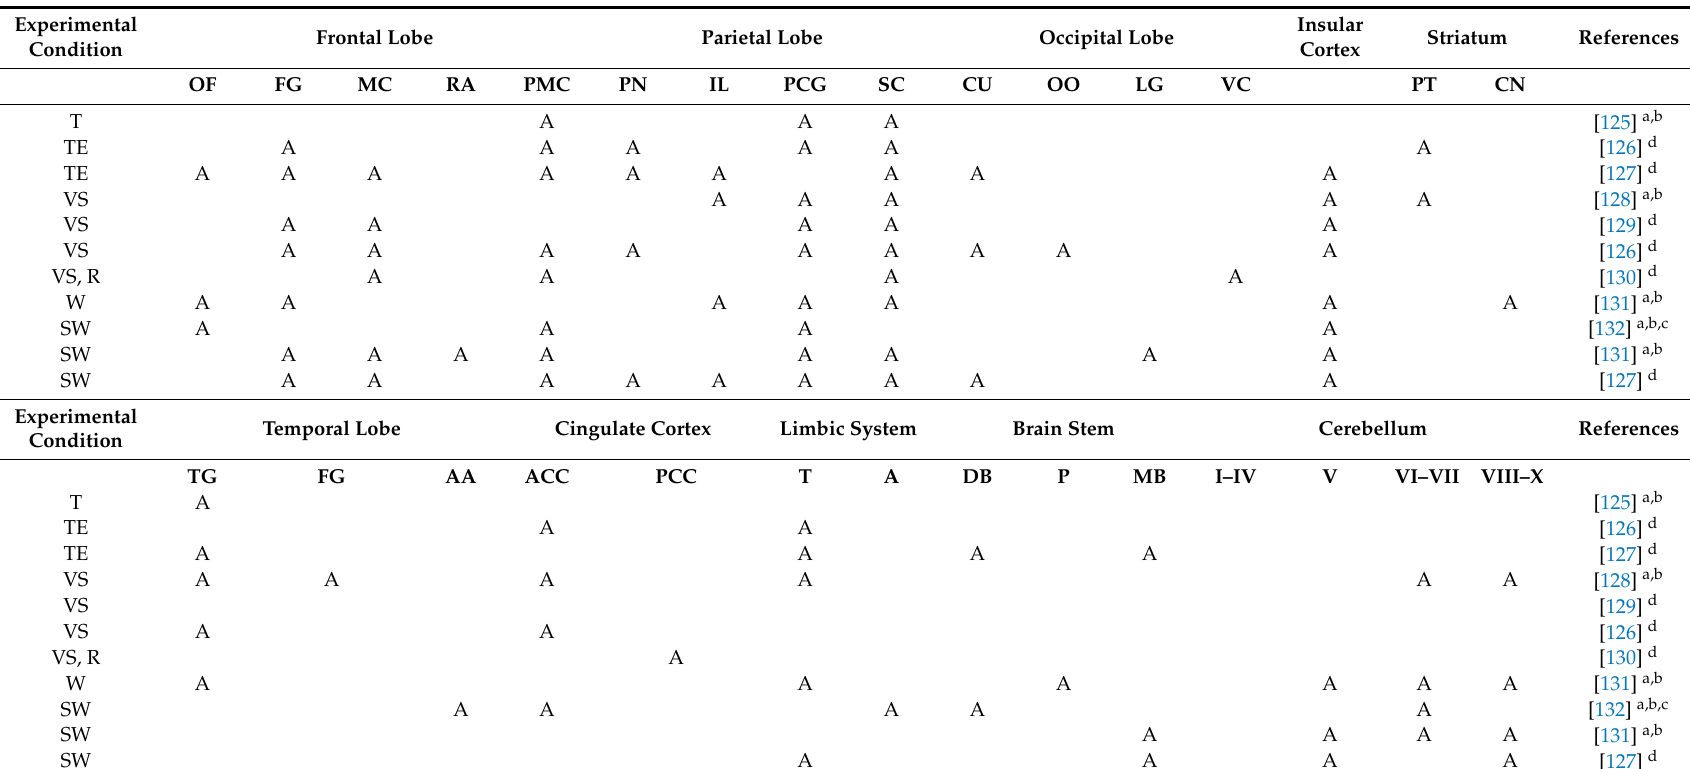
Table 4. Human brain region activations (A) in response to tongue movements, touching the tongue, water held in the mouth, and swallowing. Experimental Condition